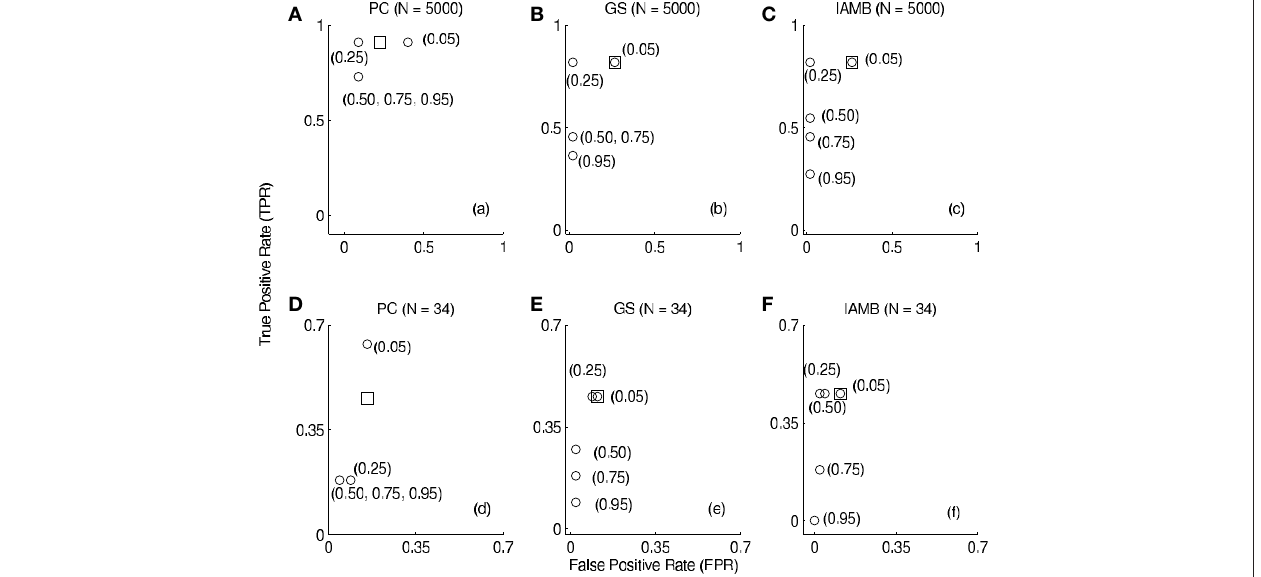
0.50, 0.75, 0.95) are shown adjacent to the circles for clarity. The circle and the square are stacked one behind the other in (B, C, e, F) around ( θ = 0.05). Multiple values in the parentheses imply the circles are stacked one behind the